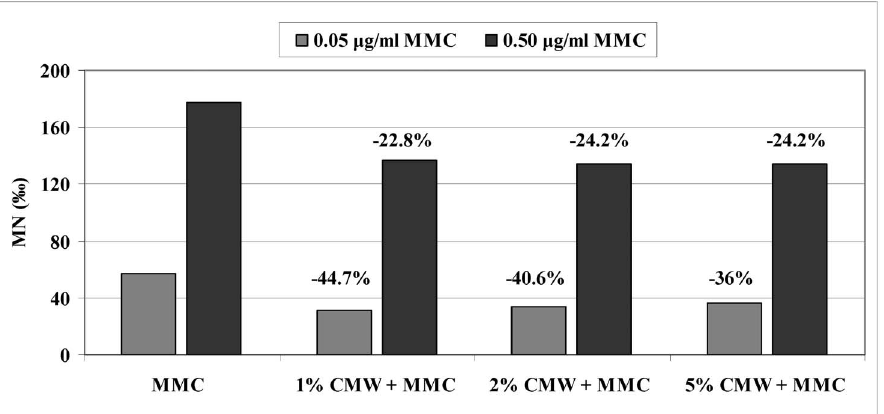
Figure 1. Reduction (%) of MN frequency induced by MMC (0.05 and 0.50 m g/ml) in presence of CMW (1, 2 and 5% v/v). doi:10.1371/journal.pone.0069494.g001 PLOS ONE |